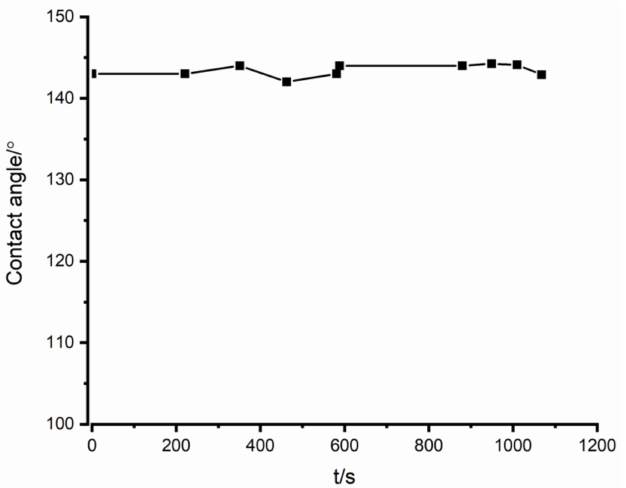
Figure 4. Contact angles as a function of time for the Fe-26Si-9B droplet on Si 3 N 4 substrate after complete